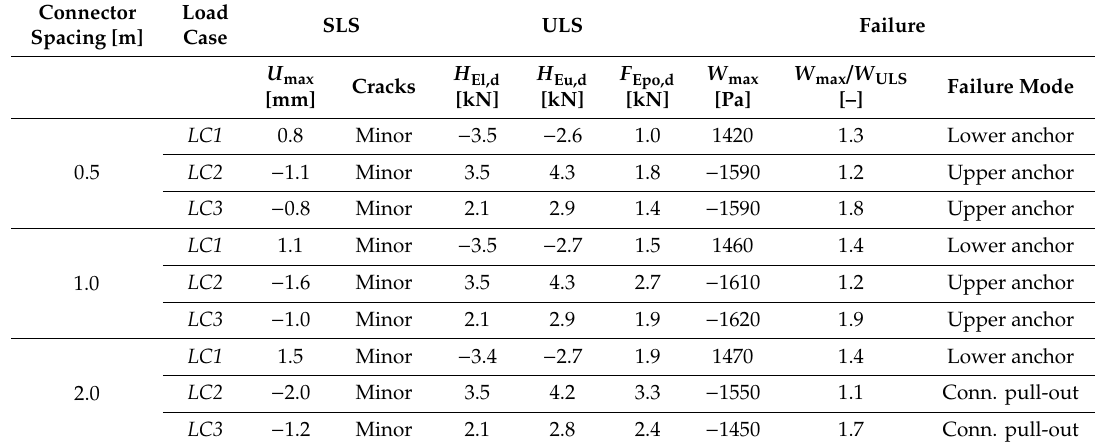
Table 5. Summary of results for the di ff erent connector distance